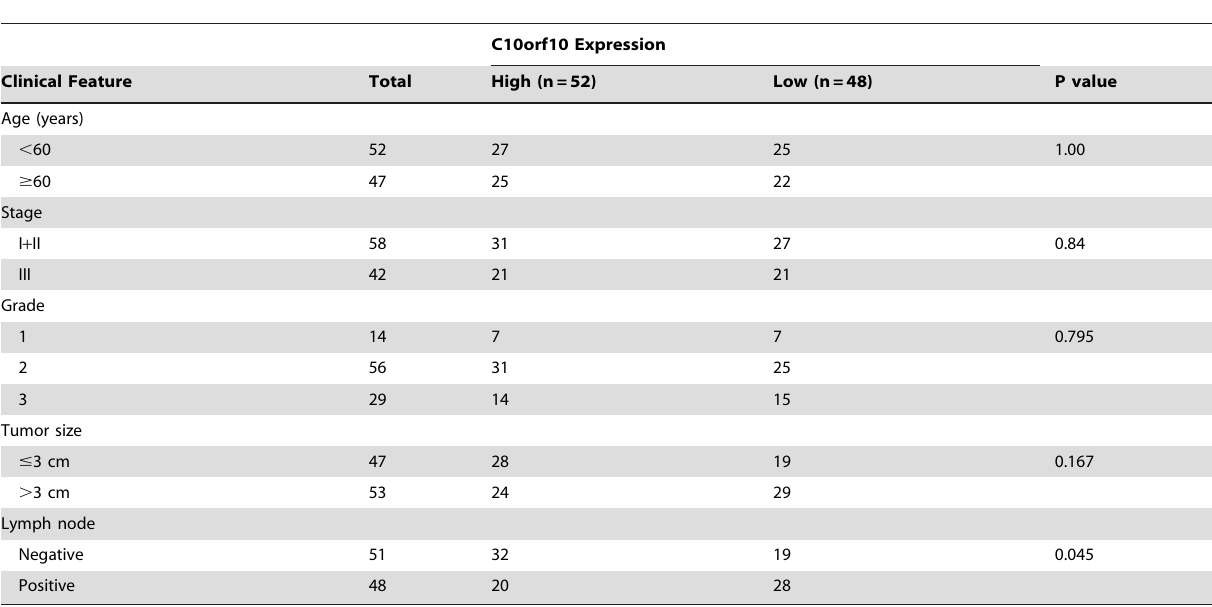
Table 2. Correlations of C10orf10 expression with clinicopathologic features of BC